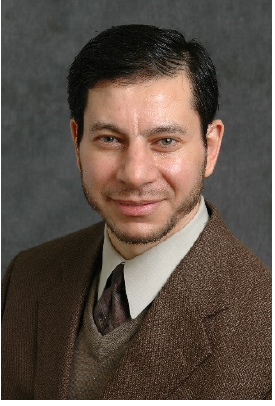
Figure 1. Dr. Kheir Al-Kodmany. As cities faces serious challenges of increasing urban population and climate change, vertical farming (VF) has the potential to play a critical role in the sustainability of